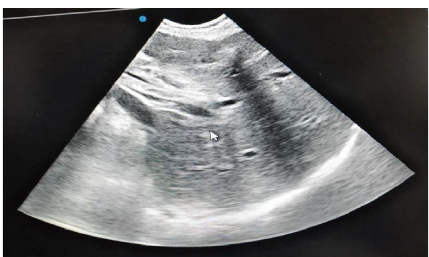
Figure 2: Ultrasound image of ascaris worm in the common bile duct, vertical